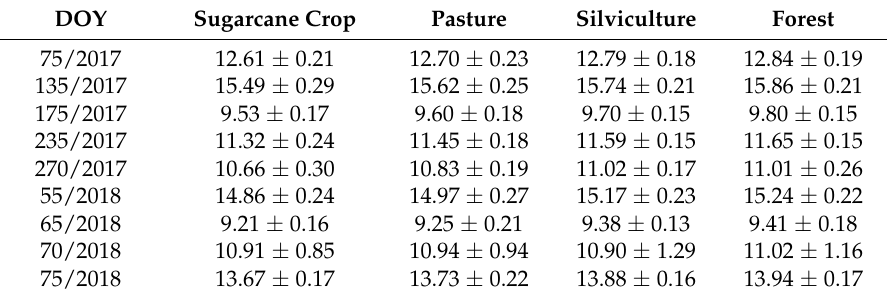
Figure 6. Net radiation (MJ) at a daily scale between 2017 and 2018 in watersheds with varied land use (DOY = day of year). Table 2. Mean values and standard deviations at a daily scale of surface albedo between 2017 and 2018 by land use and day of year